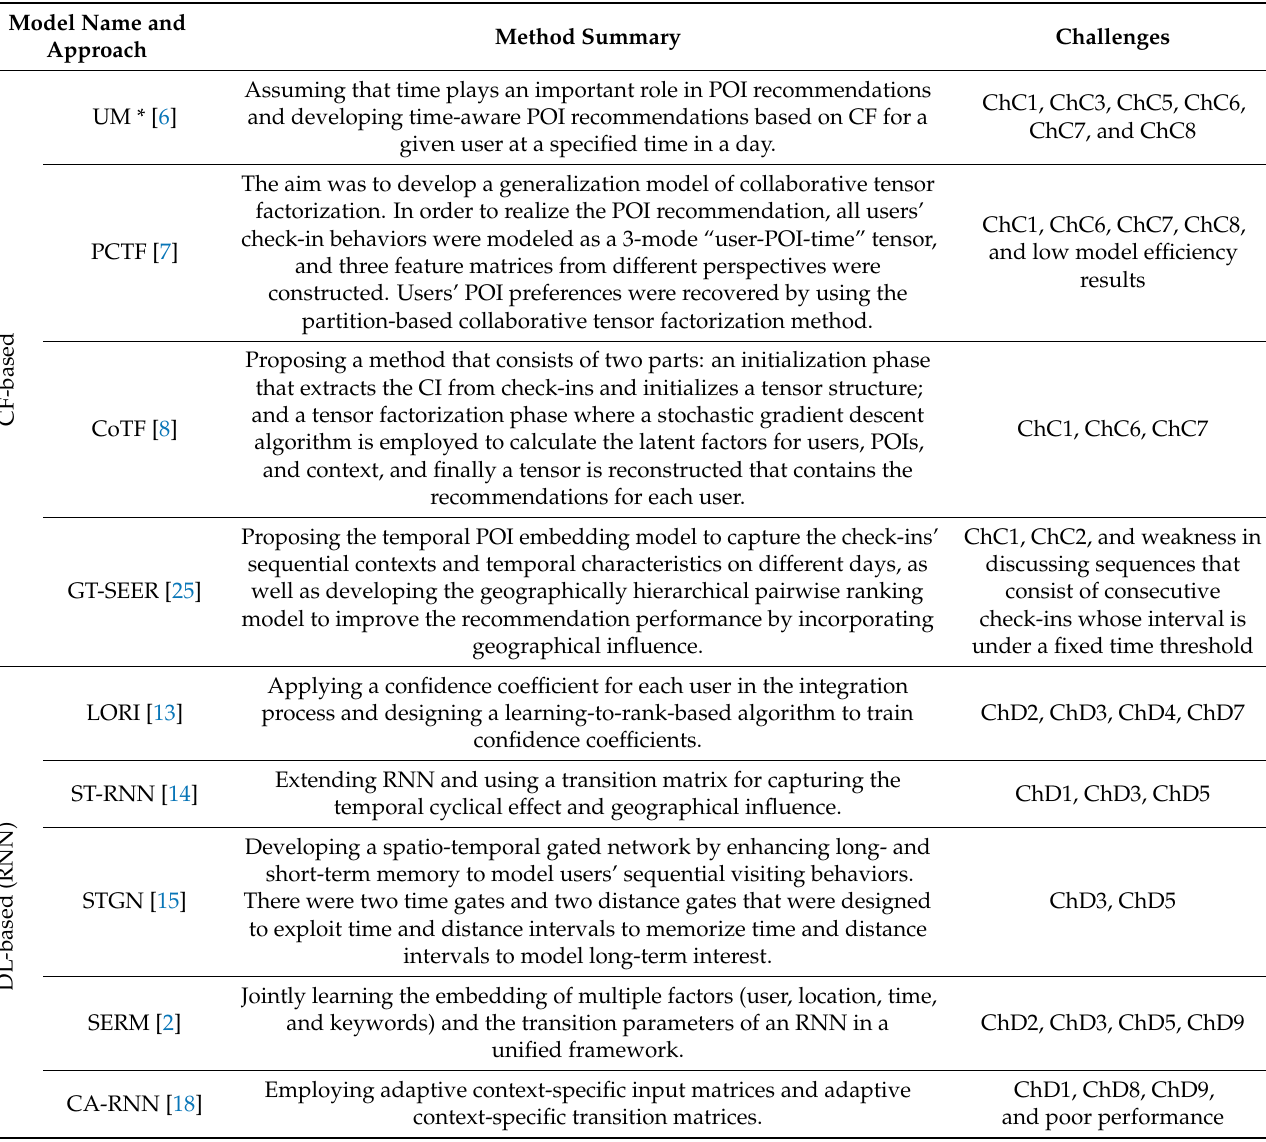
Table 1. Summary of related